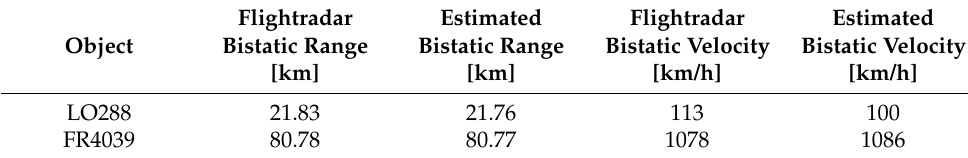
Table 5. Bistatic target parameters for the transmitter in Piatkowo—December 2019.